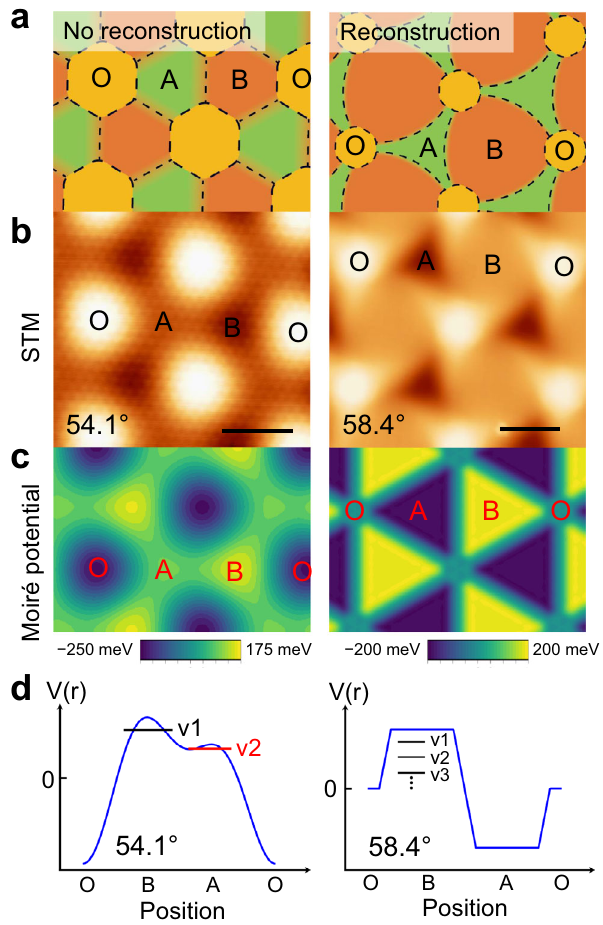
Fig. 4 Moiré potential evolution due to lattice reconstruction. a Illustration of the moiré pattern with and without twist angle-dependent reconstruction (right and left, respectively). Dashed lines mark the boundaries of O/A/B regions. b STM image of 54.1° (left, V = − 1.4 V, I = 1 nA) and 58.4° (right, V = − 1.25 V, I = 1 nA) TB-WSe 2 , showing the topographic difference due to lattice reconstruction. The scale bar is 2 nm (54.1°) and 6 nm (58.4°), respectively. c Moiré potential for 54.1° (left) and 58.4° (right) TB-WSe 2 . d Illustration of moiré potential pro fi le for 54.1° (left) and 58.4° (right) TB-WSe 2 and the corresponding con fi ned